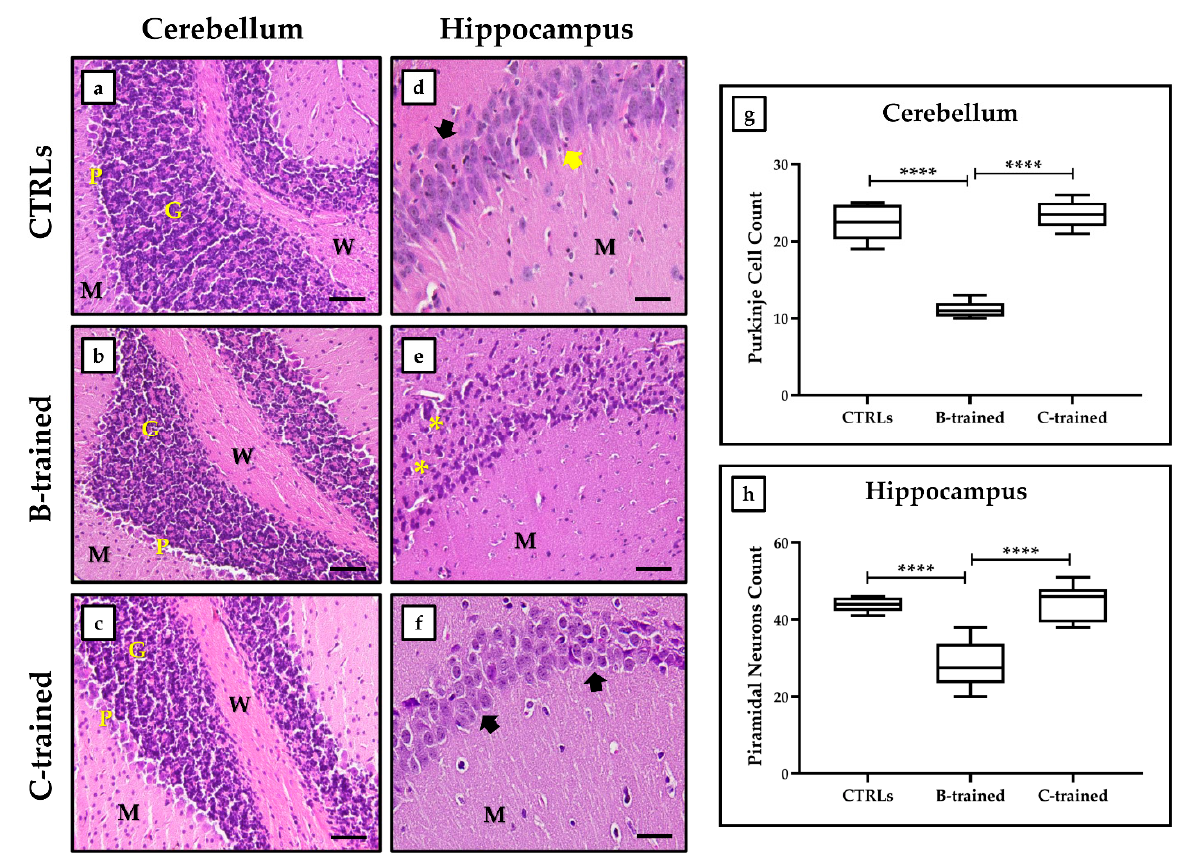
Figure 2. Haematoxylin and eosin (H&E)-stained sections of cerebellar and hippocampal tissues from the different experimental groups. ( a ) Cerebellar tissue of both CTRL groups: molecular cell layer with small, scattered basket cells and stellate cells; large pyriform cells in the Purkinje cell layer with open-faced vesicular nuclei, eosinophilic cytoplasm and prominent Nissl’s granules; granular cell layer with small, highly stained cells. ( b ) Cerebellar tissue of the B-trained group: smaller Purkinje cells with deeply stained nuclei and eosinophilic cytoplasm. ( c ) Cerebellar tissue of the C-trained group: larger Purkinje cells with open-faced nuclei. ( d ) Hippocampal tissue of both CTRL groups: pyramidal neurons (black arrow) of uniform size and arrangement, with rounded central vesicular nucleus and prominent nucleolus. Presence of many glial cells (yellow arrow) between the neuronal processes in the molecular layer is evident. ( e ) Hippocampal tissue of the B-trained group: reduced pyramidal neurons with hyperchromatic nuclei and some areas without neurons (asterisks). ( f ) Hippocampal tissue of the C-trained group: numerous and very crowded pyramidal neurons (black arrow), basophilic cytoplasm, well-formed Nissl’s granules, and vesicular nuclei. ( g ) The number of Purkinje cells in the cerebellar tissue is shown for each experimental group (CTRLs vs. B-trained, **** p < 0.0001; B-trained vs. C-trained, **** p < 0.0001; F = 111.0). ( h ) The number of pyramidal neurons in the hippocampal CA1 region is shown for each experimental group (CTRLs vs. B-trained, **** p < 0.0001; B-trained vs. C-trained, **** p < 0.0001; F = 32.34). M: molecular cell layer; P: Purkinje cell layer; G: granular cell layer; W: medulla formed by white matter fibers. 20× images, scale bar represents 50 μ m.